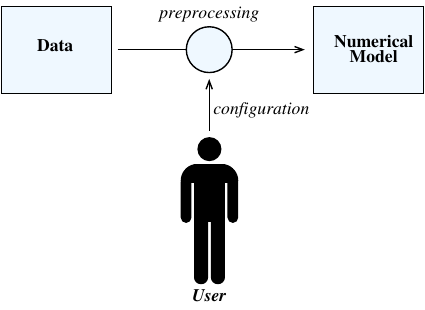
Figure 1. Isolation of the data reading and preprocessing routines from the numerical